Question: From the figure, is the trend upward or downward?
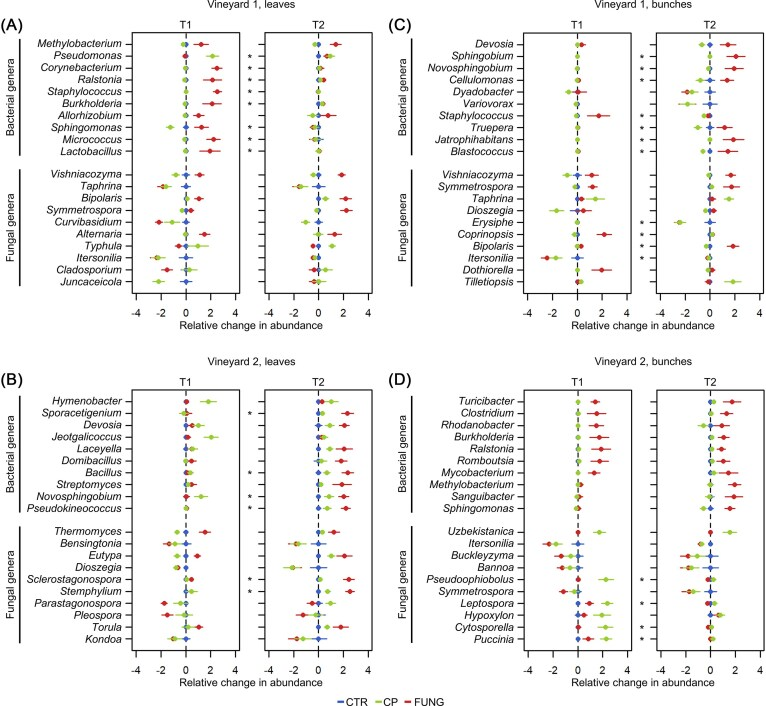
Answer: decreasing